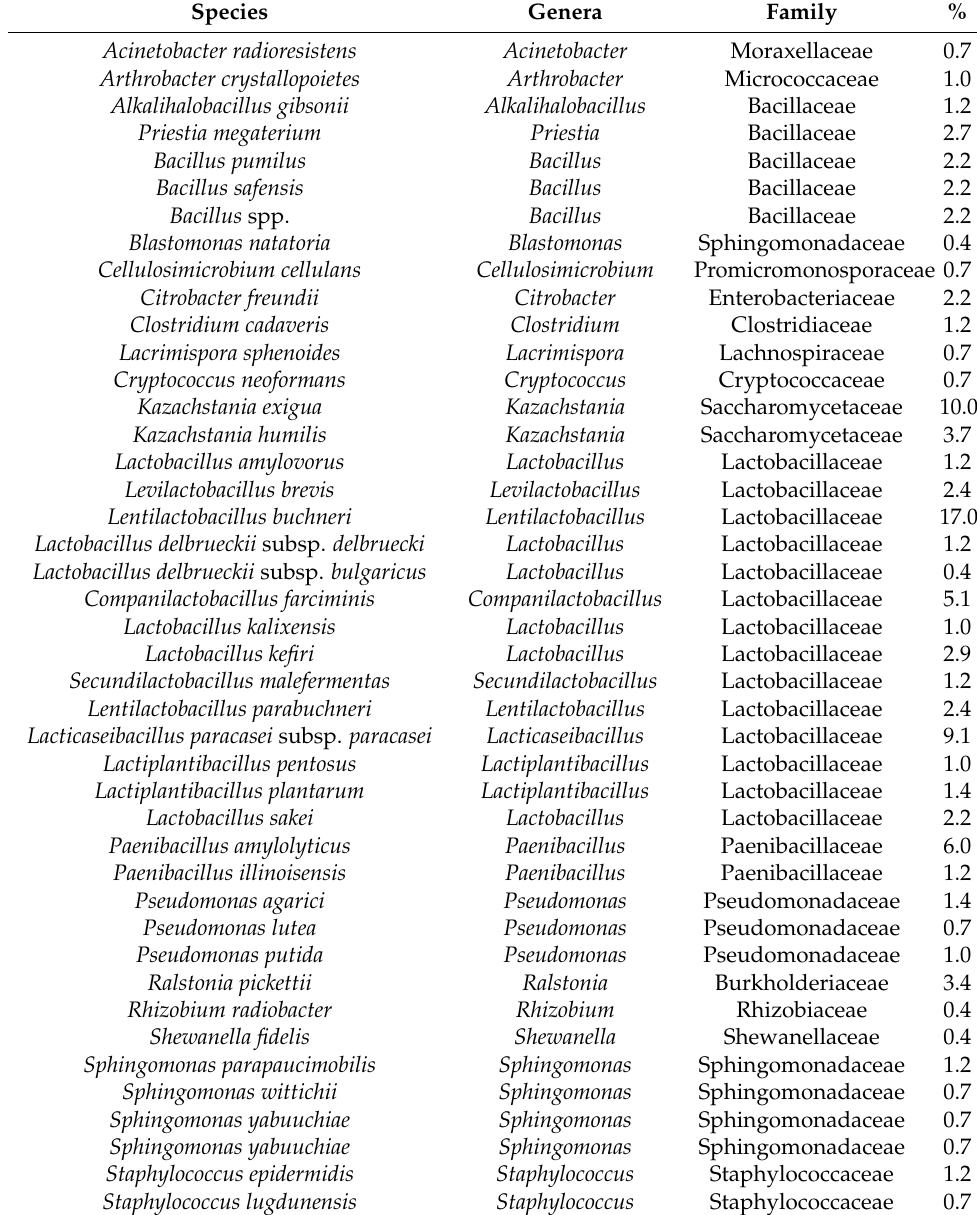
Table 4. Isolated species, genera, and families from corn silage